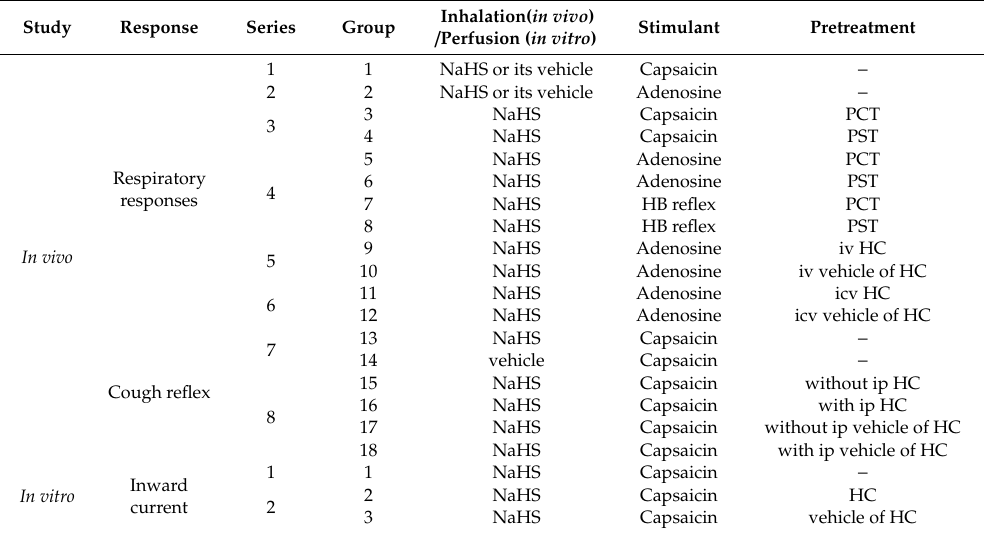
Table 2. Summary of the various experimental interventions in the study